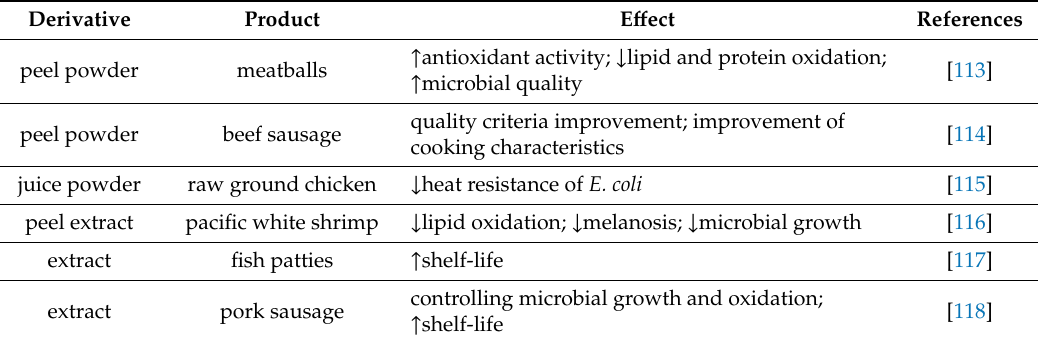
Table8. Recentstudiesonthee ff ectoftheadditionofpomegranatederivativestomeatandfishproducts.